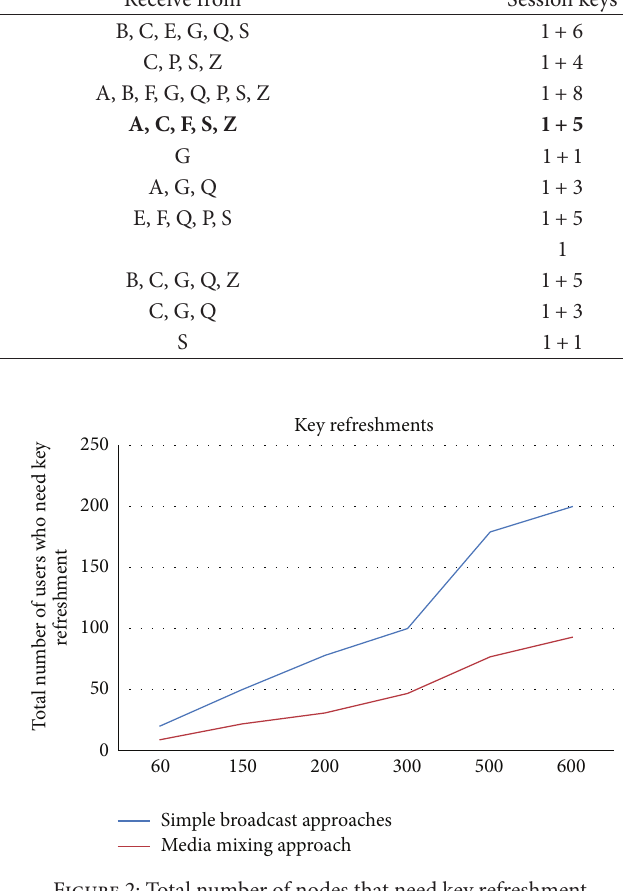
Figure 2: Total number of nodes that need key